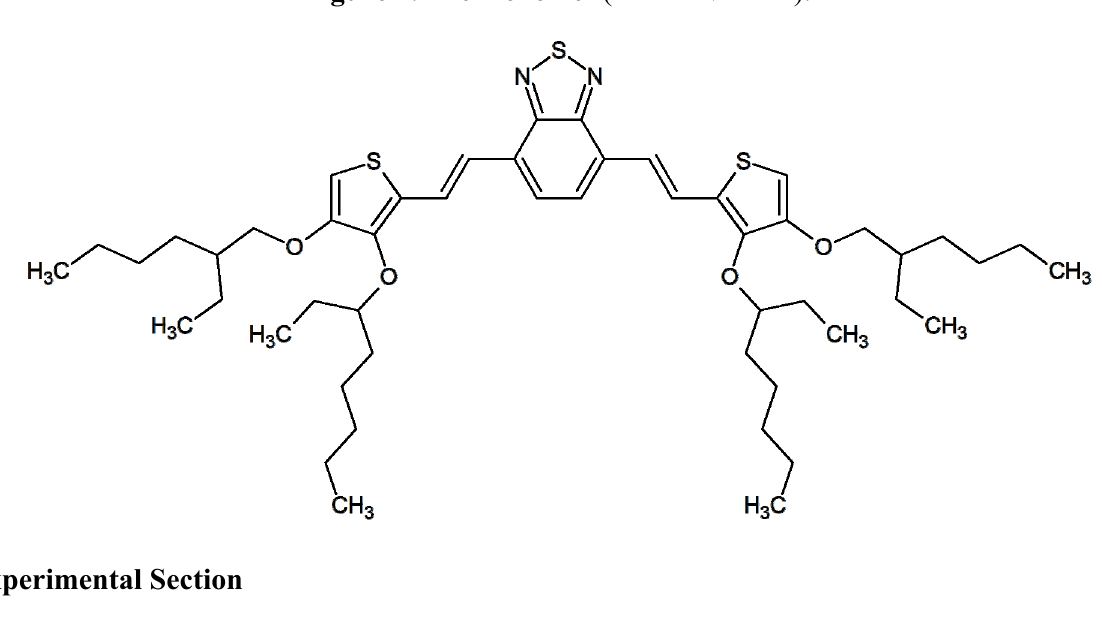
Figure 1. The monomer